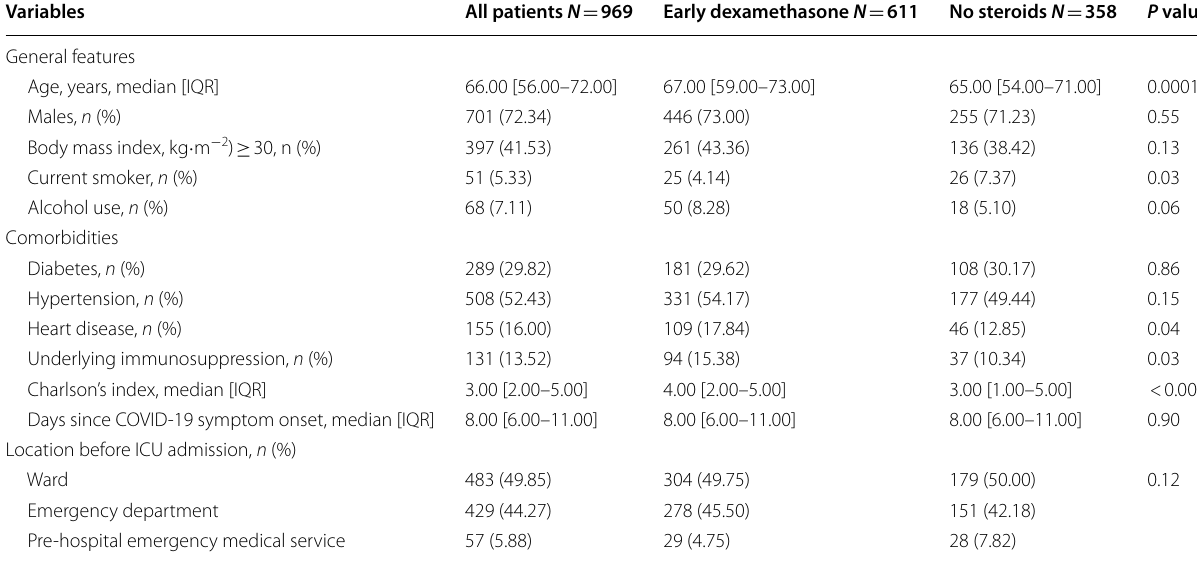
IQR interquartile range